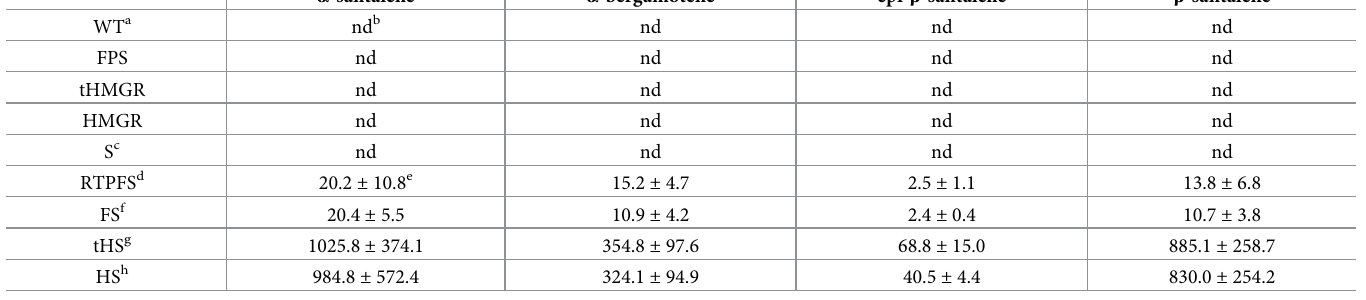
Table 1. Yields of santalenes and bergamotene in Nicotiana benthamiana using agro-infiltration (ng � g -1 fresh weight). α -santalene